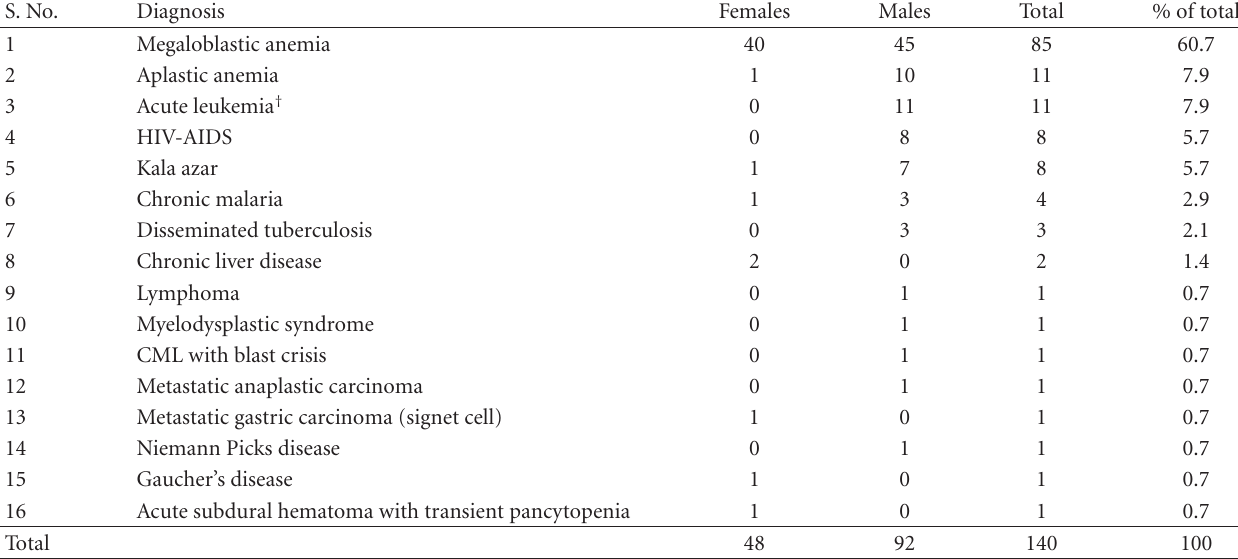
Table 1: Etiological diagnosis in pancytopenia.